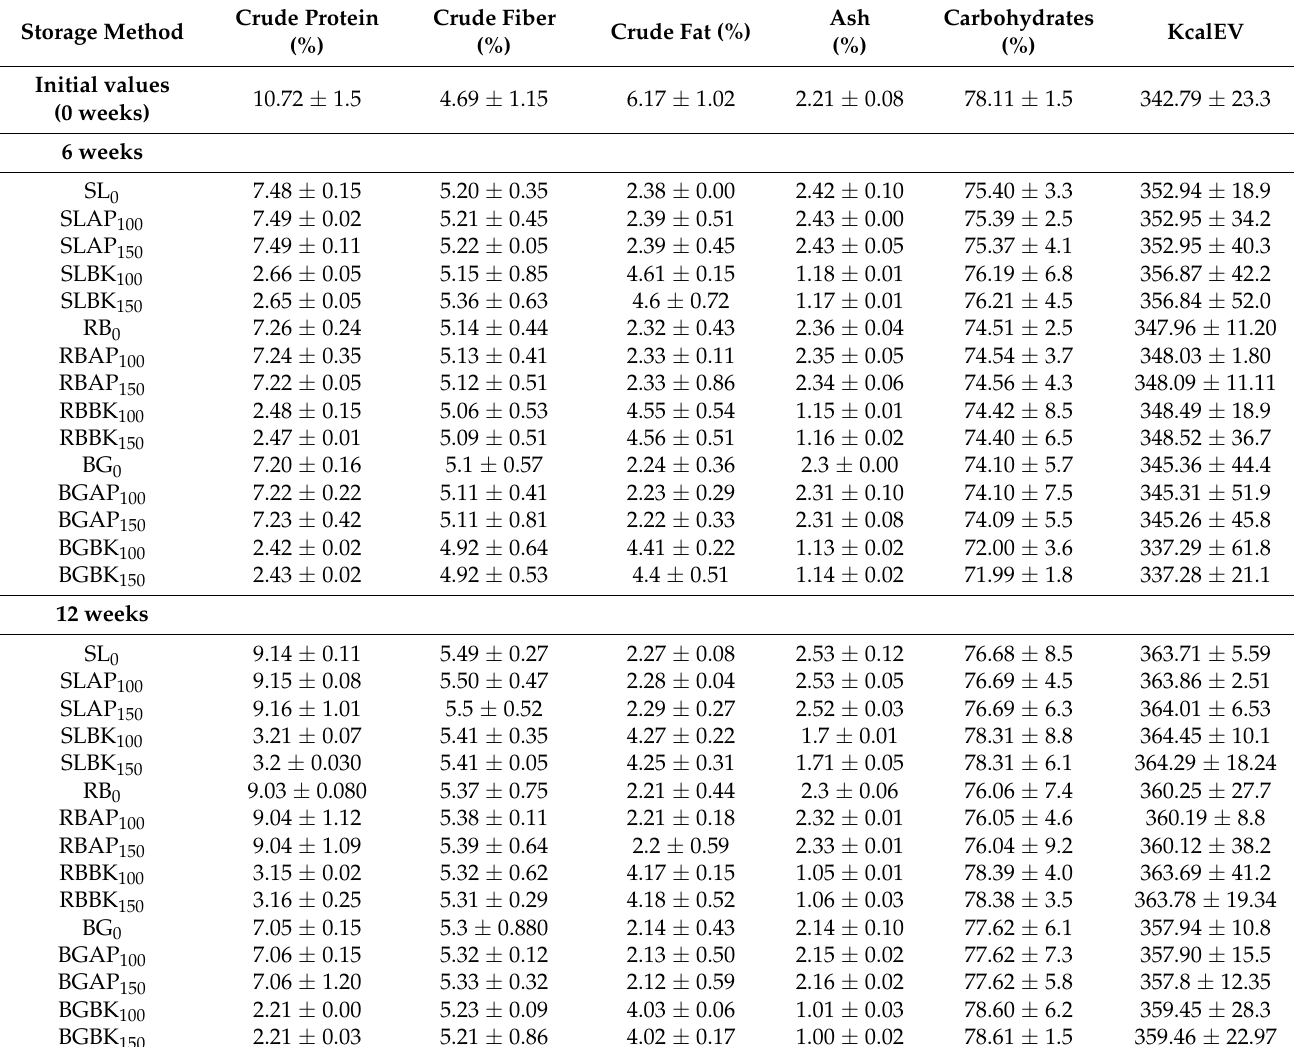
Table 4. Proximate composition of stored breadfruits with different storage strategies.